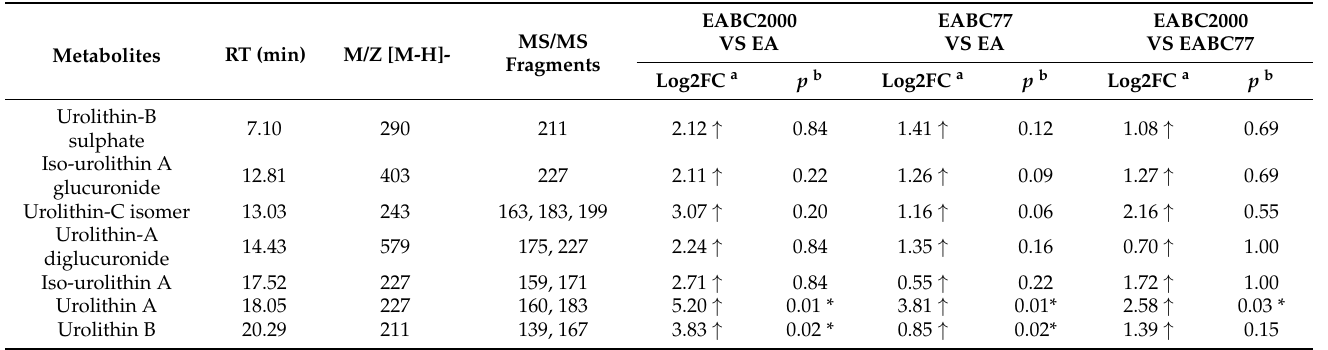
Table 1. EA metabolites identified by UPLC-ESI-QTOF-MS/MS